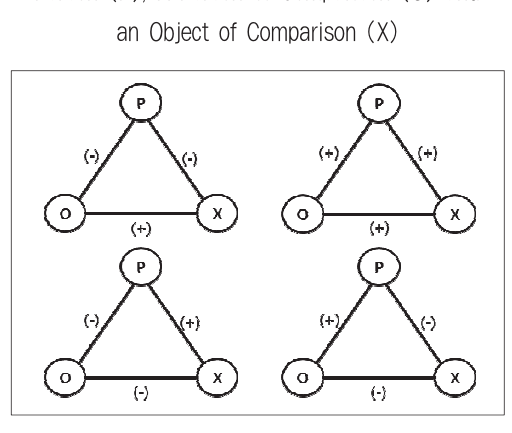
<Figure 5> Balanced States Among the Analyzing Person (P), A Person of Comparison (O) and an Object of Comparison (X)